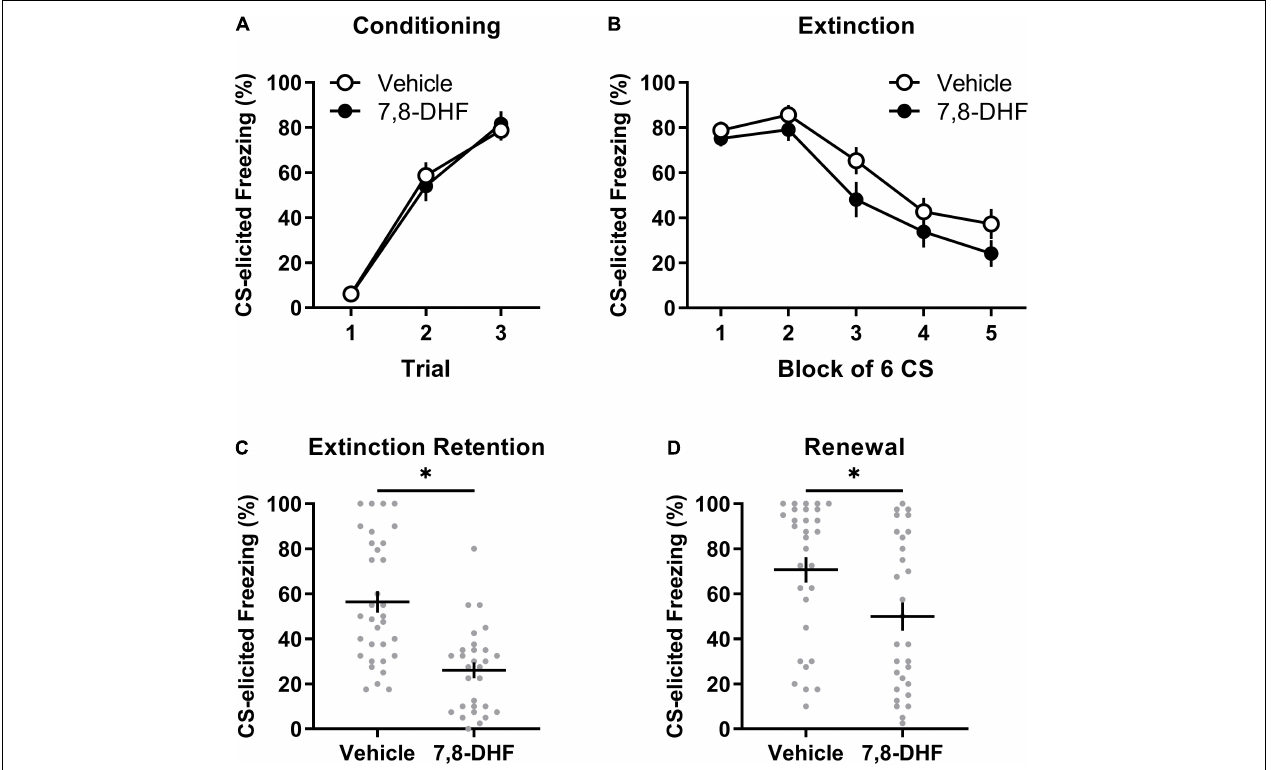
FIGURE 1 | Adolescent non-stressed rats exhibit lower levels of freezing when tested in either the extinction or conditioning contexts when 7,8-DHF is combined with extinction training. Data included in Analysis 1 are represented by mean ( ± SEM) levels of CS-elicited freezing at Conditioning (A) and Extinction (B) . CS-elicited freezing data at the Extinction Retention (C) and Renewal tests (D) are shown as individual dot plots with mean ( ± SEM). Asterisk represents significant ( p < 0.01) group difference. Group sizes were n = 33 for vehicle and n = 29 for 7,8-DHF with the exception of n = 26 for 7,8-DHF at extinction training and n = 30 for vehicle at the renewal